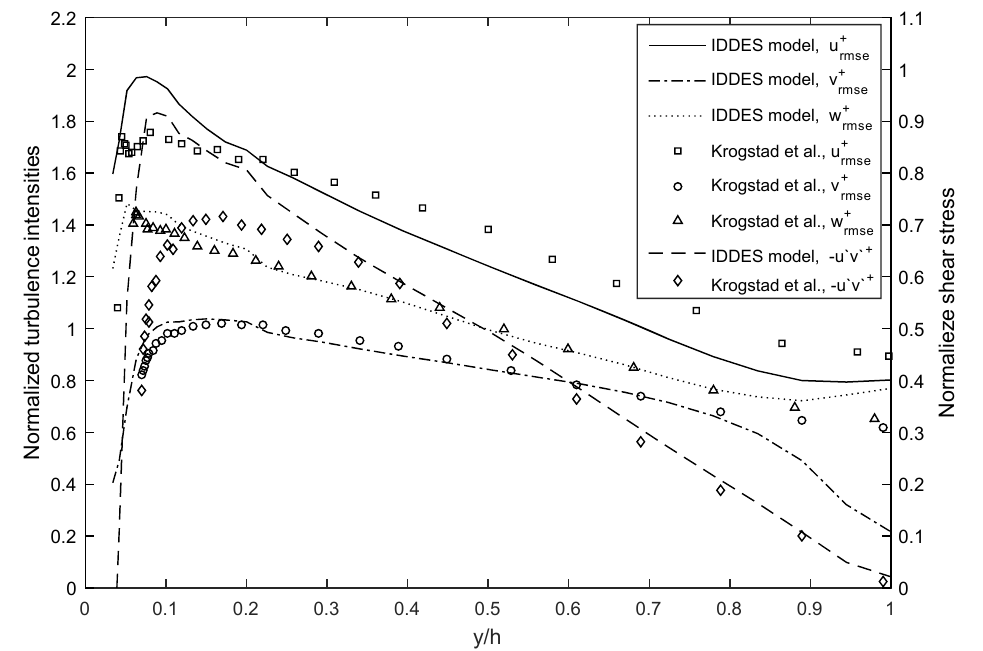
Figure 3. Normalized turbulent intensities and Reynold stress profiles of IDDES calculation results and Krogstad et al.’s measurements [29].